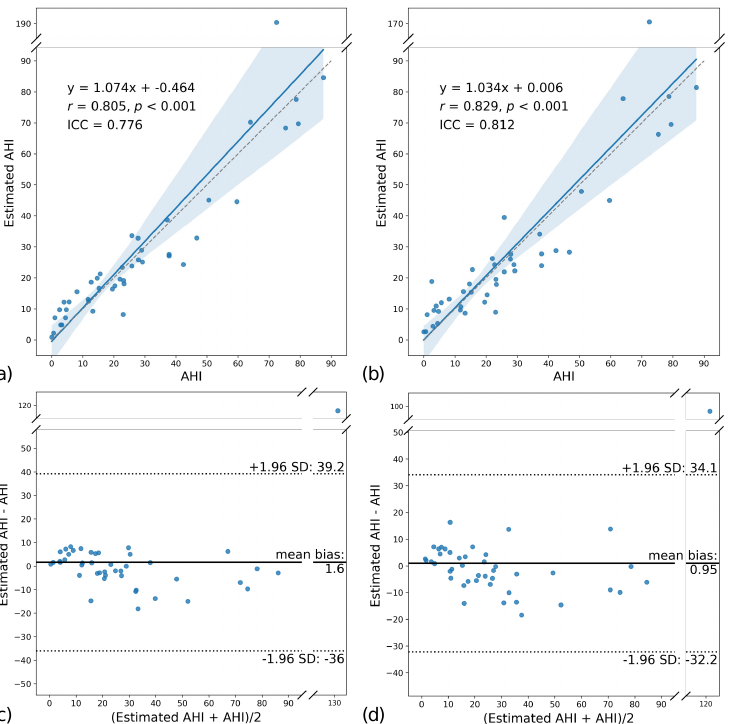
Figure 7. Comparison of the estimated AHI with the ground truth for the binary ( a , c ) and multiclass models ( b , d ). ( a , b ) Scatter plots of estimated AHI versus AHI showing the linear regression line (blue line) with 95% confidence intervals (blue shadowed area). ( c , d ) Bland–Altman plots of estimated AHI and